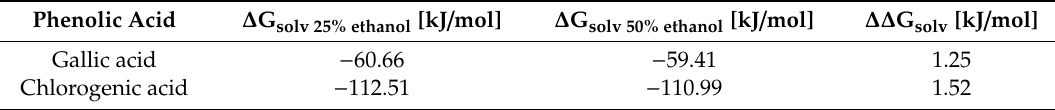
Table 3. Changes of the Gibbs free energies of solvation of chlorogenic and gallic acids in ethanol-water systems with increasing ethanol